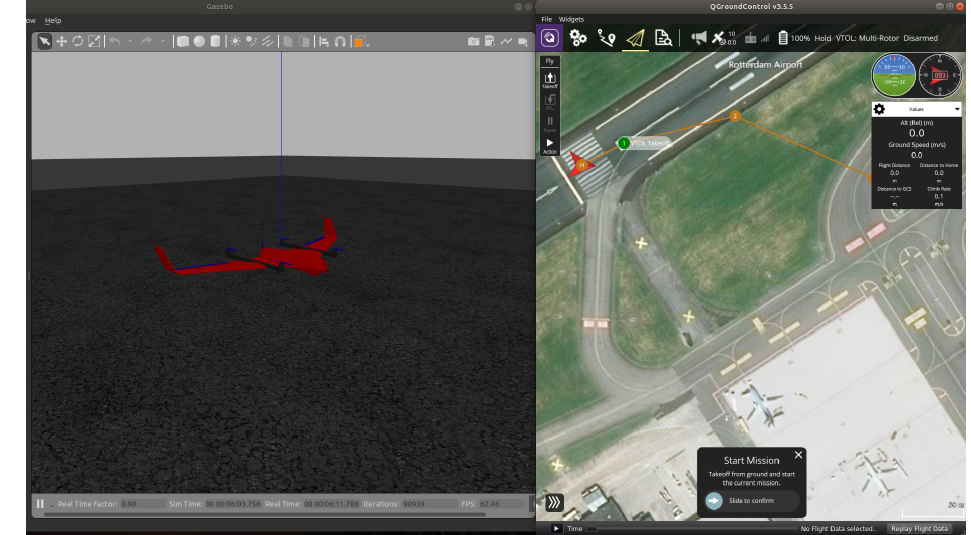
Figure 3. Gazebo with ground control